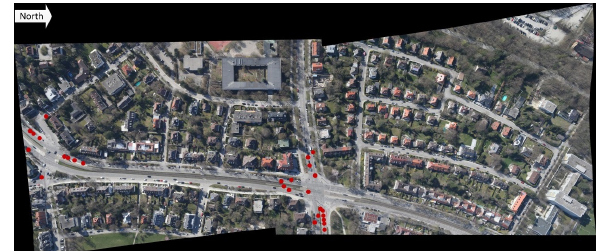
Figure 7. Selected vehicles near to traffic lights.